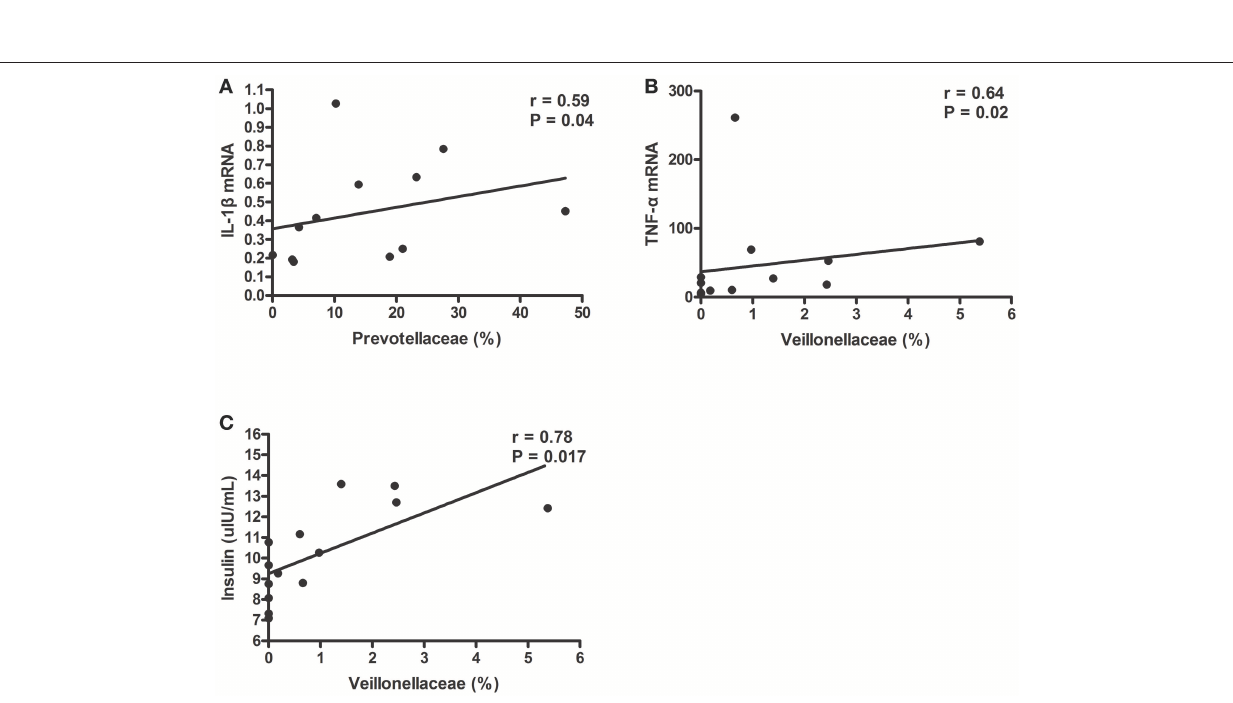
Frontiers in Physiology | www.frontiersin.org